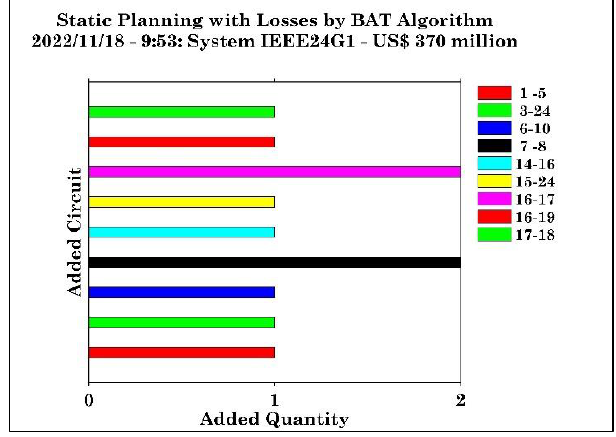
Figure 10: Case WOR - IEEE-24/41 test system. Planned circuits. Source: BATp optimizer, (2022).